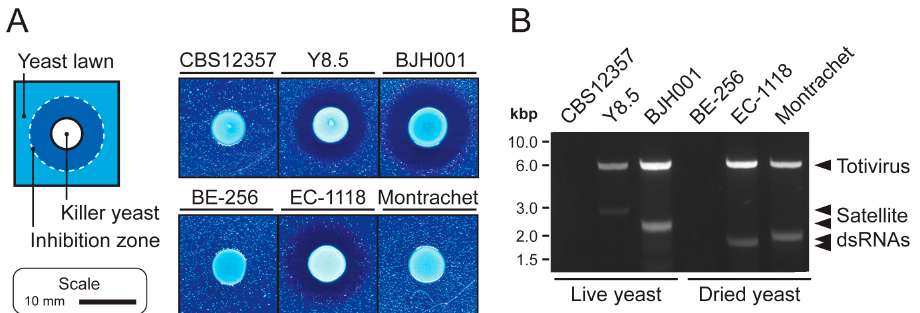
Figure 1. The extraction of dsRNAs from dried and actively growing cultures of killer and non-killer Saccharomyces yeasts. ( A ) Killer toxin production by different strains of Saccharomyces yeasts.